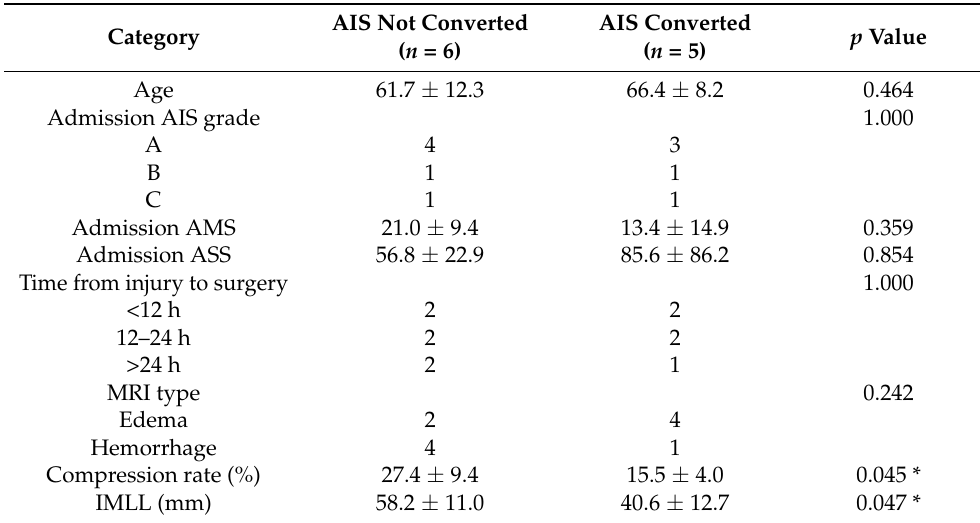
Table 3. AIS grade conversion in various categories of the